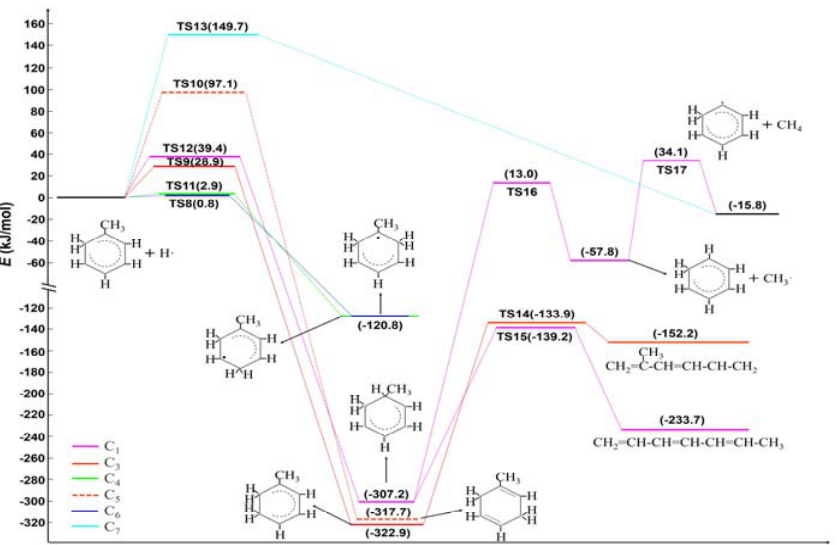
Figure 3. Energy profiles of hydrogenation and hydrocracking by the second H atom for first-generation hydrogenated products.